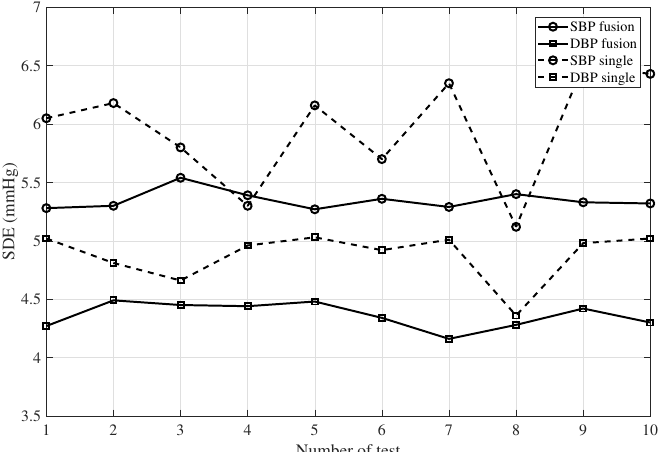
Figure 5. Summary of the SDE (ME) obtained utilizing the DBMDS estimator vs. DBM single estimator as the number of test increases according to the AAMI (American association of medical Instruments) standard protocol, where mean (5.34) and standard deviation (STD) (0.08) of SDE obtained from the DBMDS estimator vs. mean (5.96) and STD (0.47) of SDE obtained from the DBM estimator for the SBP, and mean (4.36) and STD (0.11) of SDE obtained from the DBMDS estimator vs. mean (4.85) and STD (0.22) of SDE obtained from the DBM estimator for the DBP.